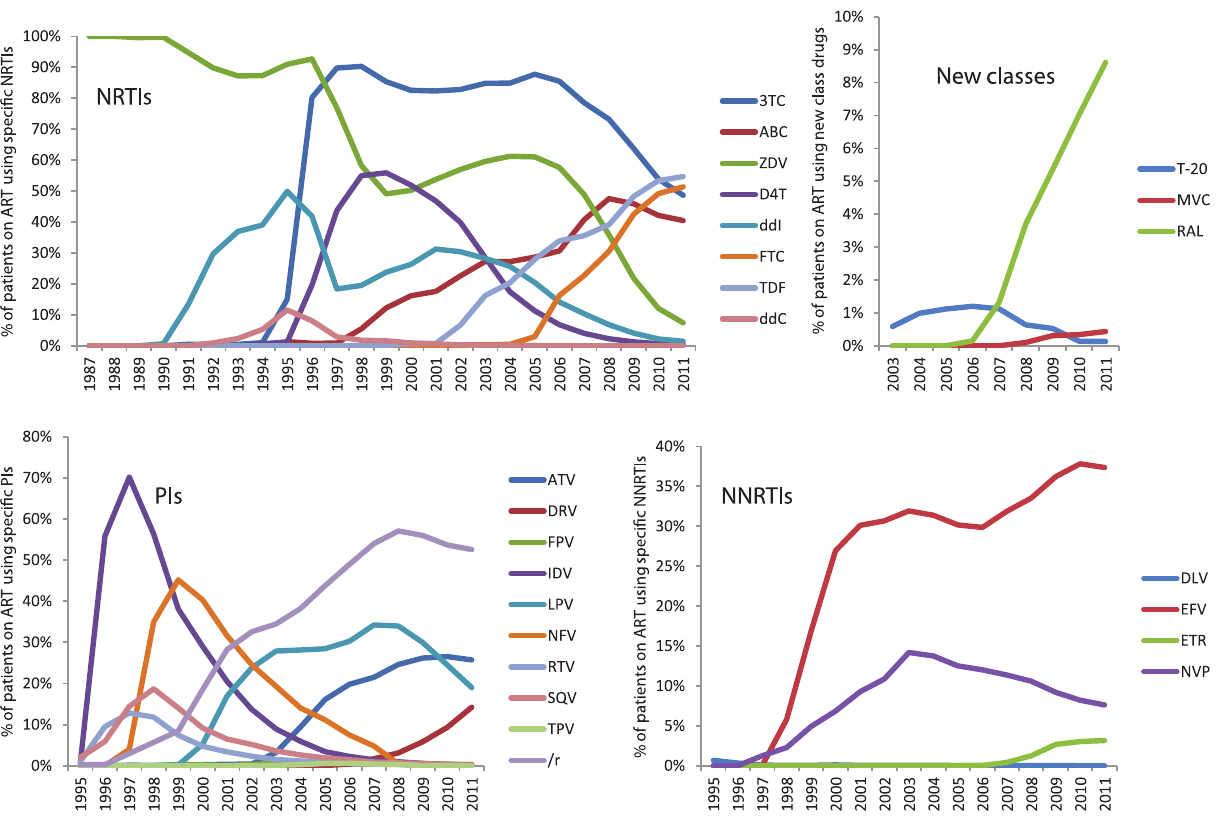
Figure 1. Antiretroviral drug use in Sweden 1987–2011. The graphs depict the proportion of patients on ART exposed to each individual drug per calendar year, revealing trends in usage prevalence overtime.